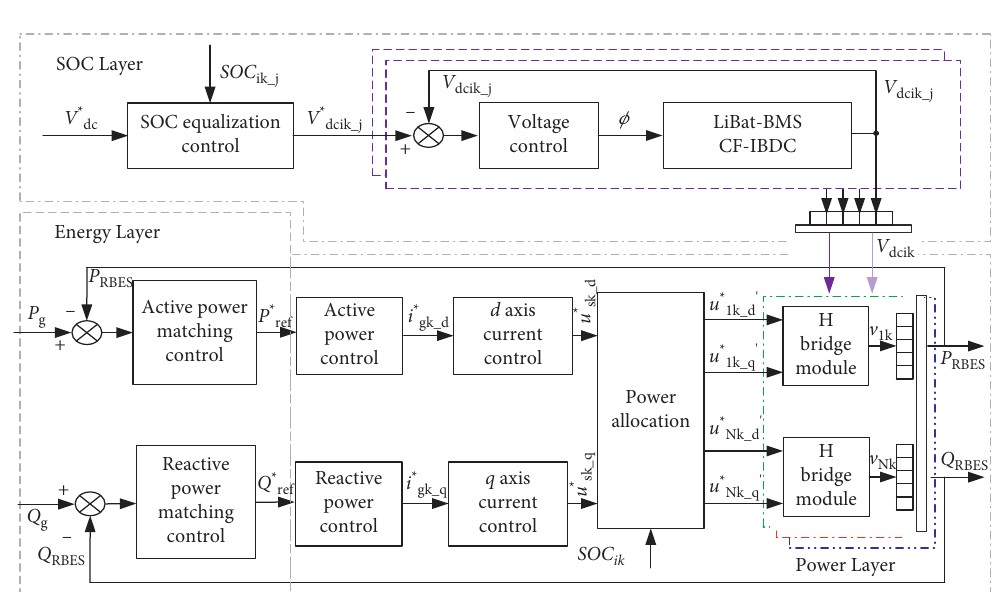
Figure 4: Block diagram of hierarchical control